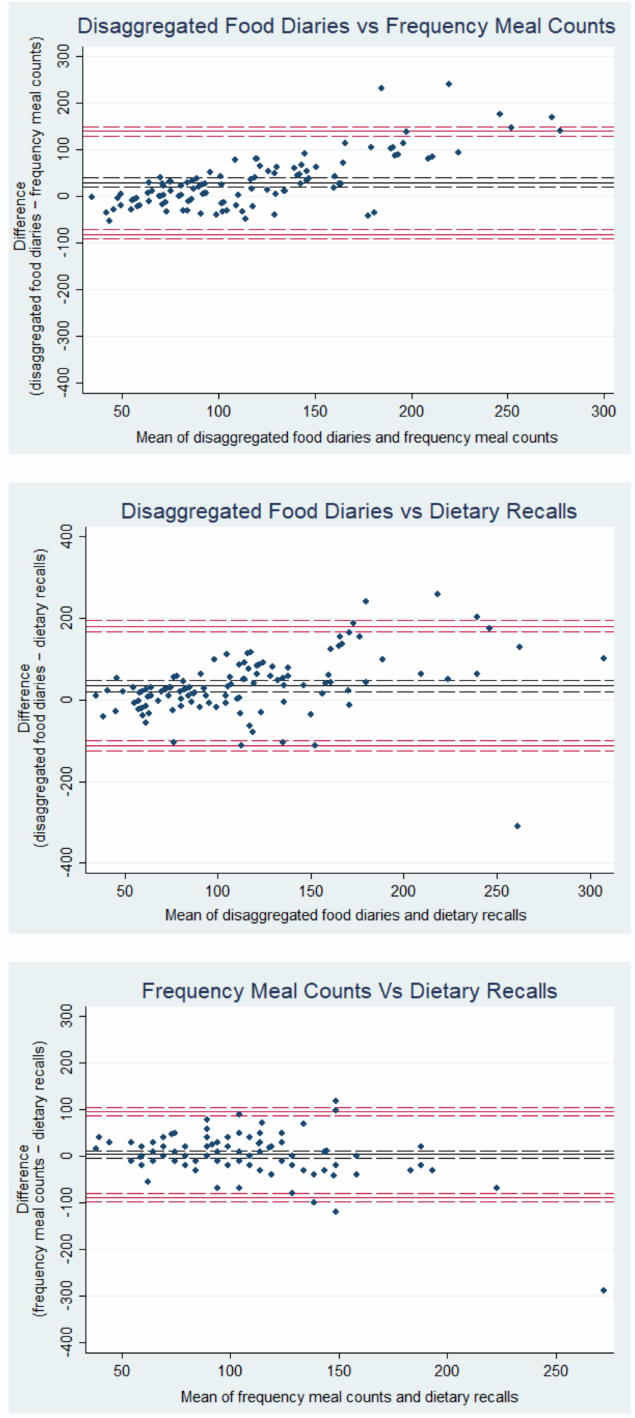
Figure 1. Bland-Altman plots showing the comparability of three methods to estimate meat intake (g/day). Disaggregated food diaries: disaggregating the quantity of meat from meat-containing composite products recorded in 7 day food diaries; frequency meal counts: counting the frequency of meals containing meat recorded in 7 day food diaries*standard portion size; dietary recalls: asking participants to retrospectively recall how many times they consumed meat in the last 7 days through a questionnaire*standard portion size. Solid red lines are the limits of agreement with 95% confidence intervals (red dashed lines). The solid black line is the mean difference (bias) together with the 95% confidence intervals (black dashed